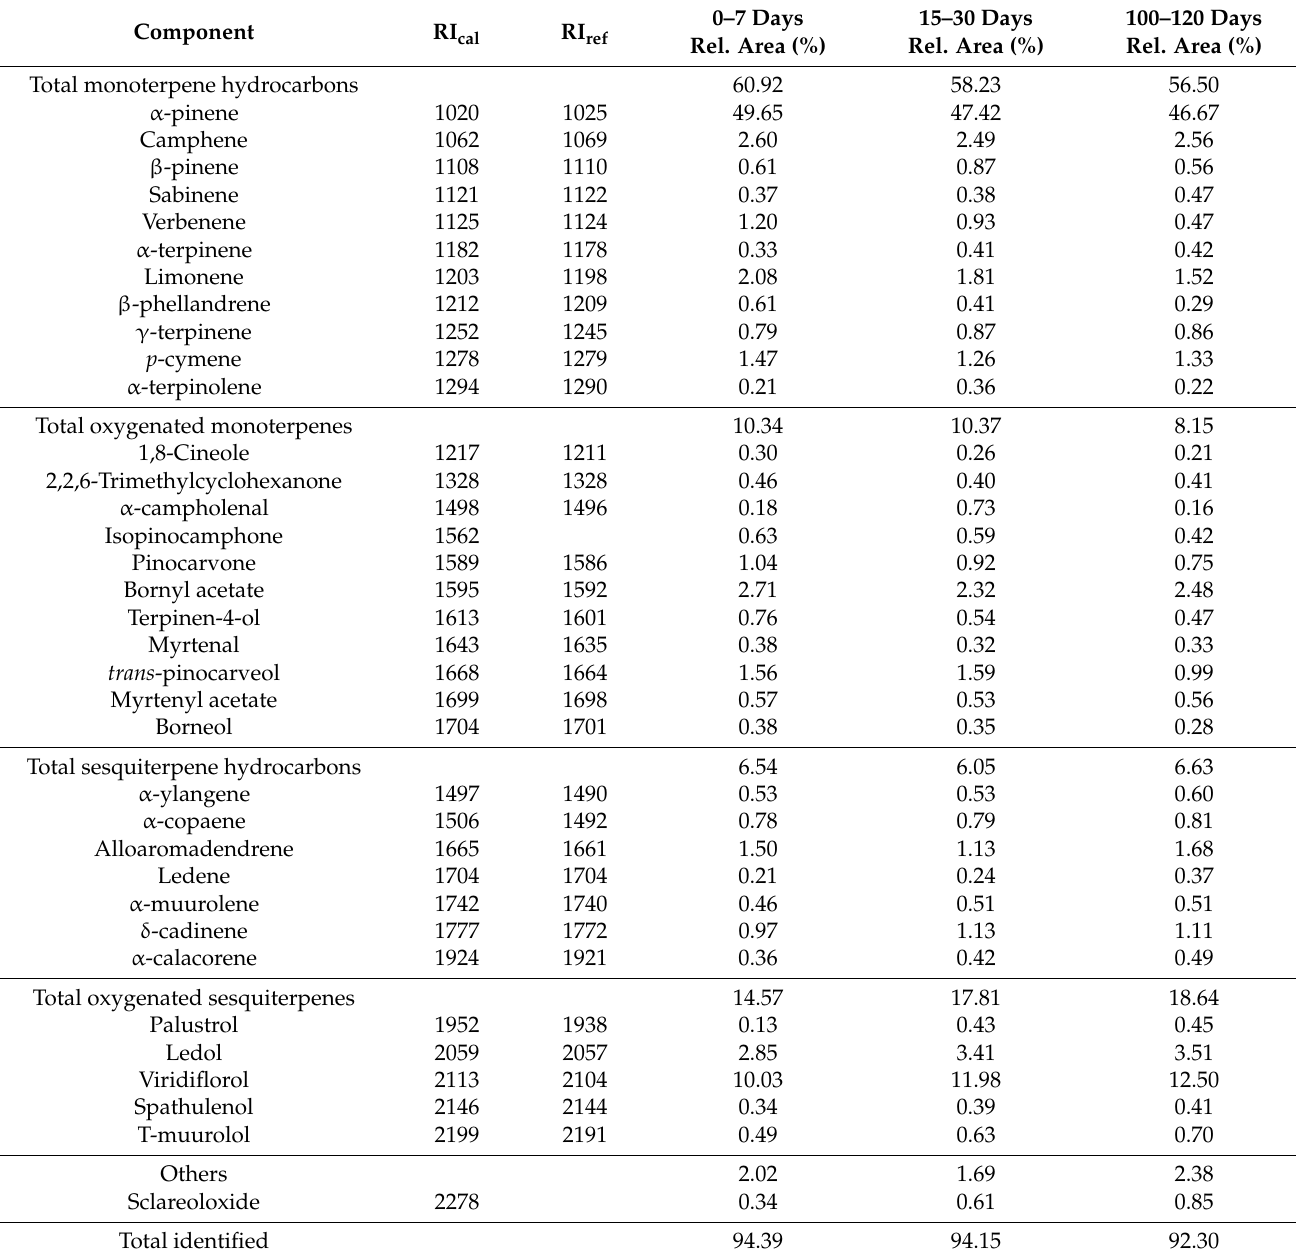
Table 2. Main components ( ≥ 0.3%) of Cistus ladanifer essential oil analysed by GC-MS and